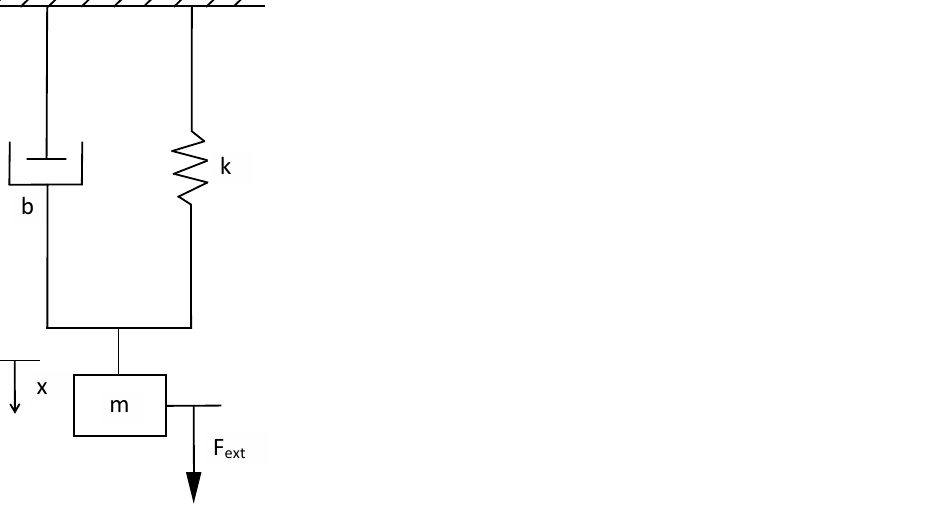
Figure 3. Mass-spring-damper to obtain the second-order transfer function in mechanical